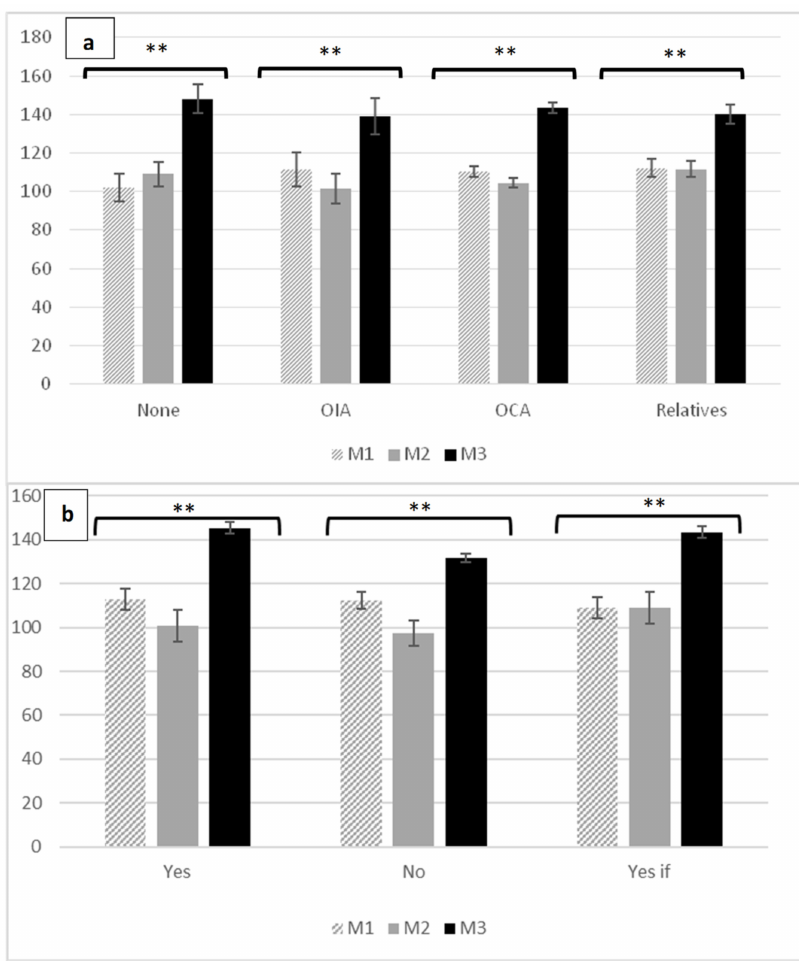
Figure 5. ( a ) (previous experiences): M1: Moment 1; M2: Moment 2; M3: Moment 3; OIA: previous experience with older institutionalized adults; OCA: previous experience with older community adults; Relatives: previous experience with older relatives at home; ** p < 0.001. ( b ) (preference of work): M1: Moment 1; M2: Moment 2; M3: Moment 3; Would you like to work with older people after your studies? Three possible answers: Yes, No, or Yes if: Only if I do not find work in another area; ** p < 0.001. Kogan’s score in the presence of previous experiences with older people and